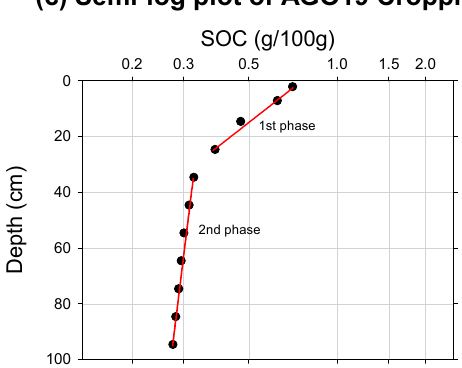
Figure 6. Examples of the sensitivity of semi-log plots to depth profiles of SOC. ( a ) fitted power functions (SOC = B zC) to the paired sites AGO 18 and 19, showing differences in the exponential response with depth. ( b ) AGO site 18 shows three potential phases as a result of the accumulation of soil organic matter in the near surface soils. ( c ) This accumulation of soil organic matter in the near surface soil is not apparent in the cropping site (AGO 19). Note the natural logarithmic scale for graphs ( b , c ).